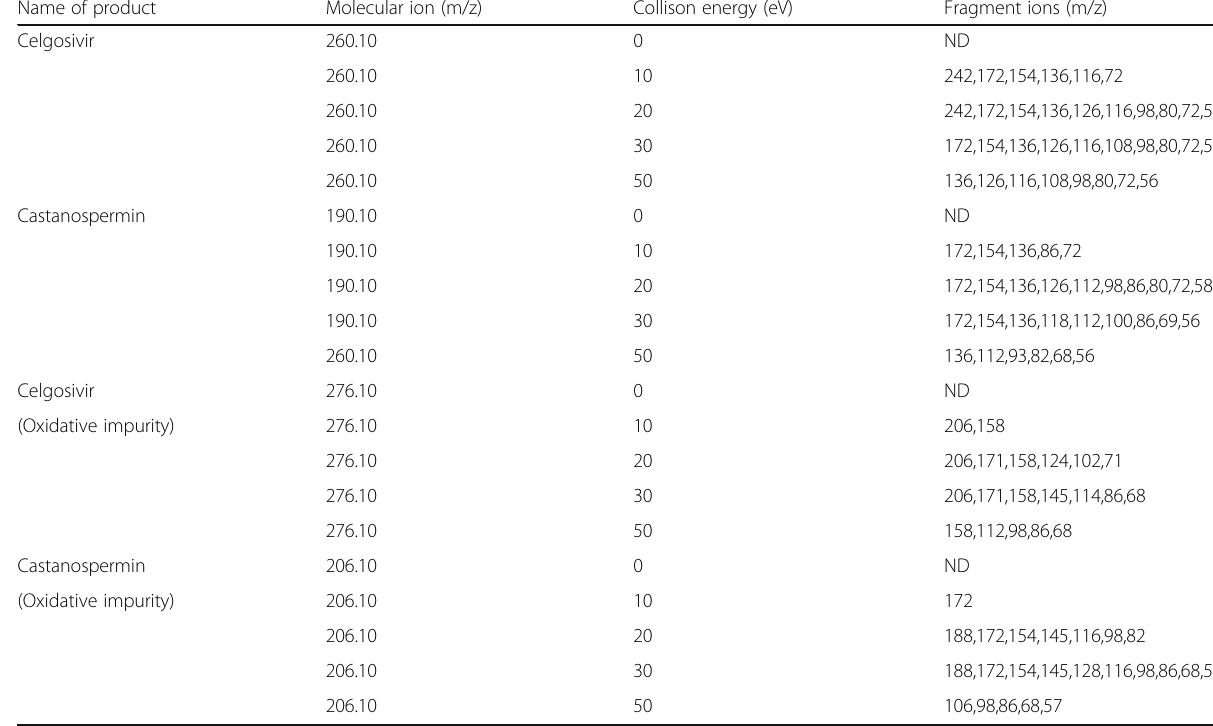
Table 1 m/z values of castanospermin, celgosivir, and its oxidative